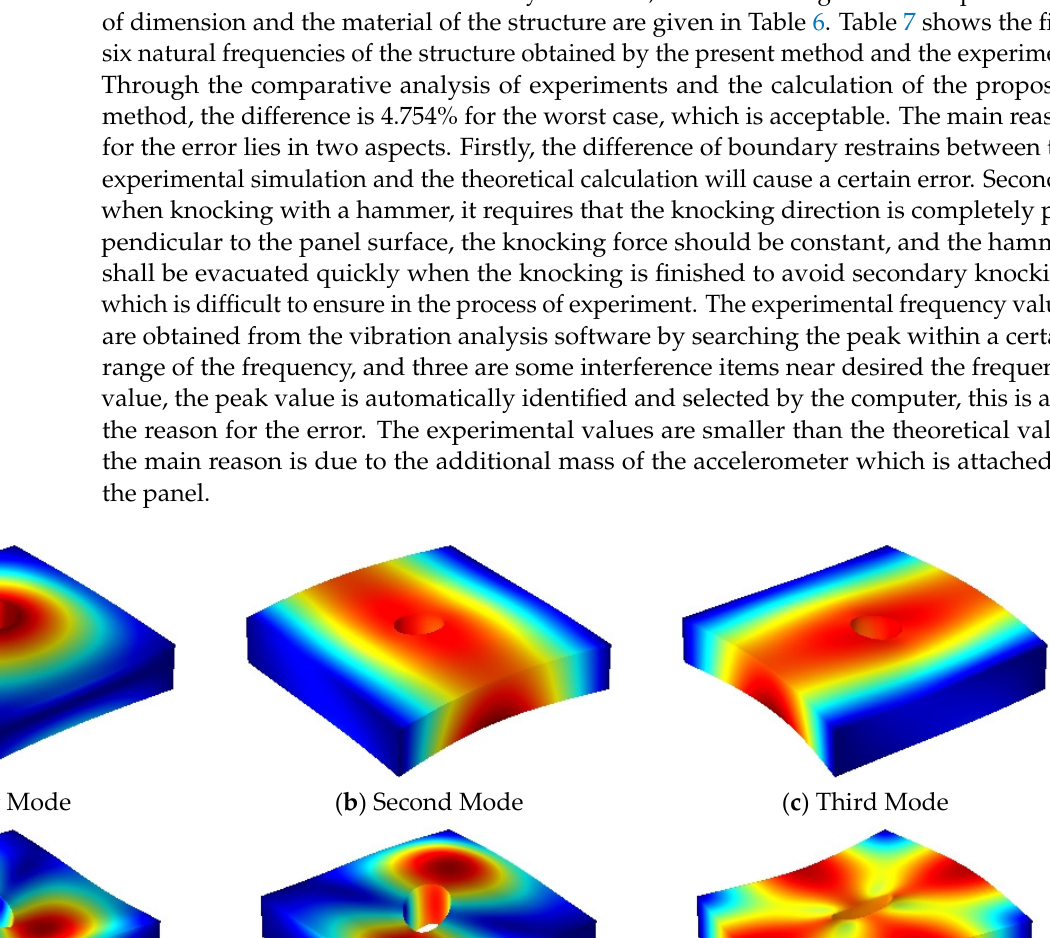
Materials 2021 , 14 , x FOR PEER REVIEW